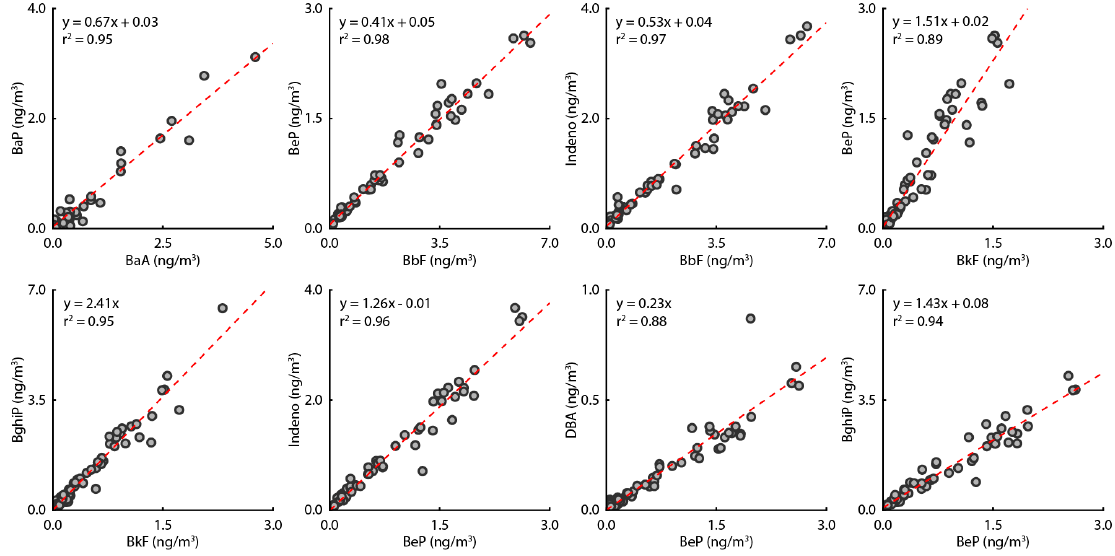
Figure 4. Scatter plots between PAHs.